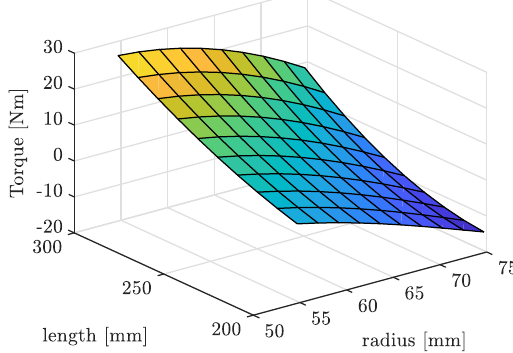
Figure 8. PMSM torque with respect to stator outside radius and axial length.